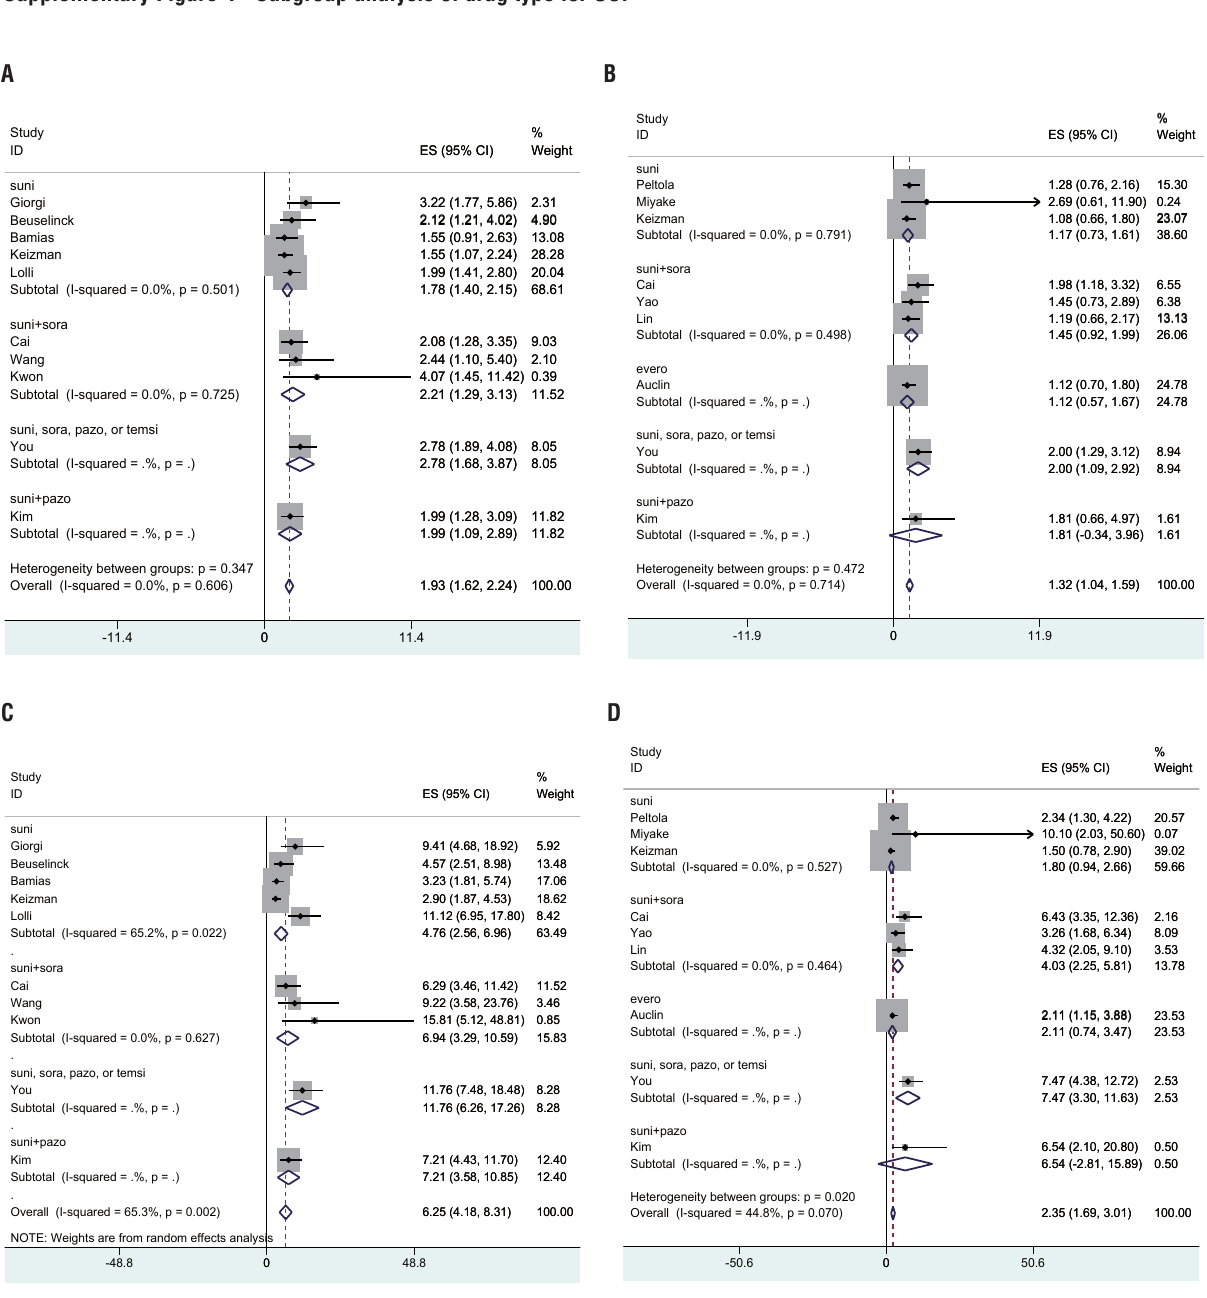
Supplementary Figure 4 - Subgroup analysis of drug type for